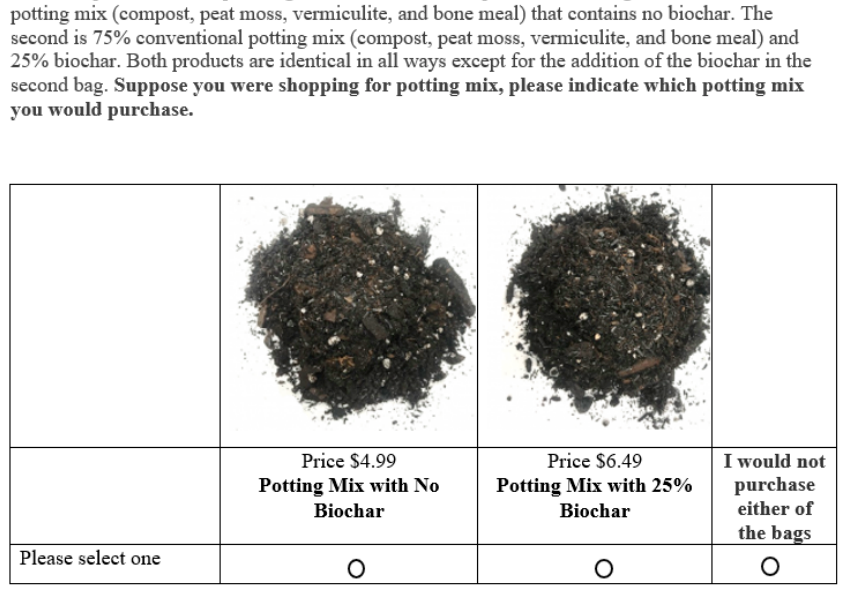
Figure 1. Example choice set for potting mix.